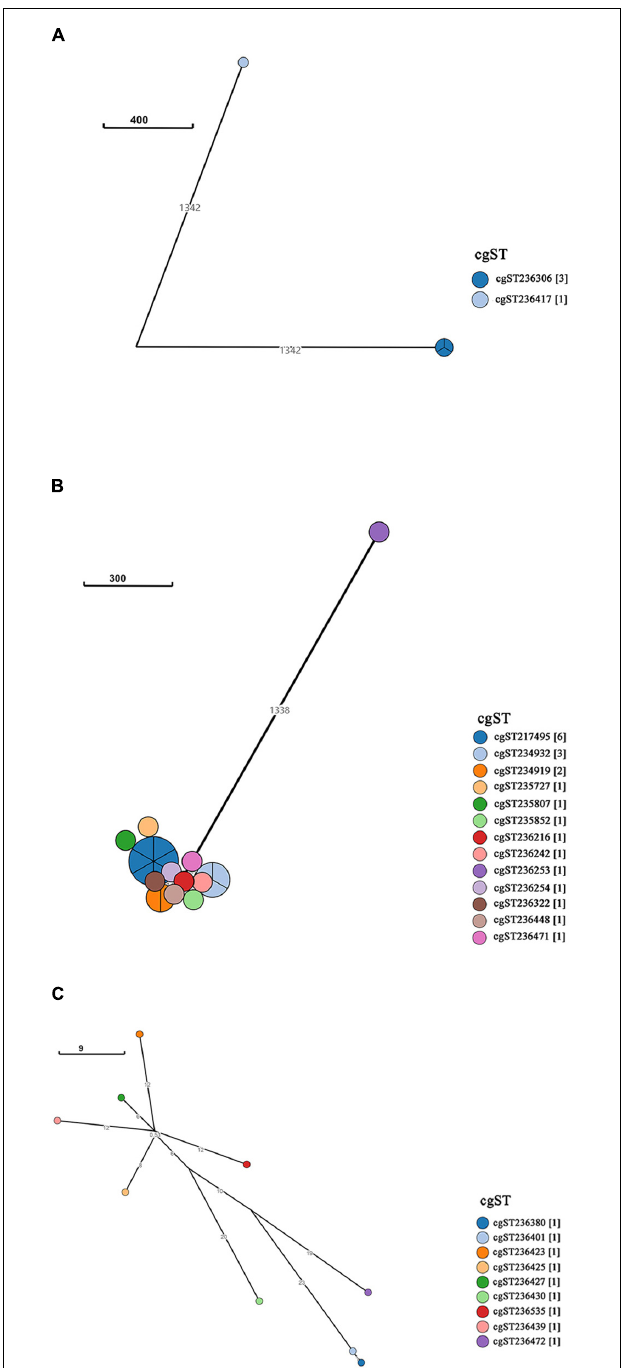
FIGURE 4 | GrapeTree of Salmonella serovar Saintpaul, Derby, and I 4,[5],12:i:- isolates. GrapeTree constructed based on the 3002 core genes by EnteroBase GrapeTree using NINJA neighbor-joining algorithm. (A) GrapeTree among the four serovar Saintpaul isolates, where every node means different cgST and the line between two nodes indicates a long distance ( ≥ 1000); (B) GrapeTree of the 21 Derby and 1 cgST (cgST236253) isolates with a long genetic distance ( ≥ 1000) to other cgSTs; (C) GrapeTree of the nine serovar I 4,[5],12:i:- and nine cgST isolates with nodes indicating they all have a relatively close genetic distance ( ≤